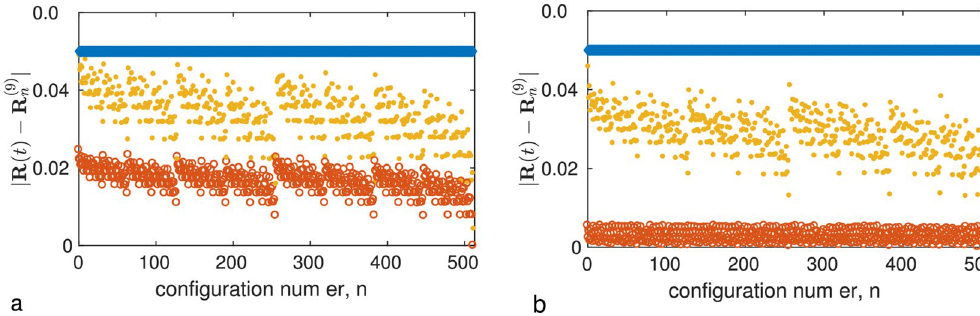
Figure 7. Numerical simulation of Eqs. (3) and (6) for a nine-leaf star network with 512 different initial ( 9 ) conditions R ( 0 ) , each of which is close to the state R n of a particular predicted asymptotic configuration with number n = 0, . . . , 511 . Panels ( a ) and ( b ) correspond to the sigmoid boundary function with µ = 0.01 and the Heaviside step boundary function, respectively. The frequencies (ω 1 , . . . , ω 8 , ω 0 , ω 9 ) , written in ascending order, are equidistantly distributed in the interval [0.6, 1]. The states R ( 0 ) are chosen so that the initial distances | R ( 0 ) − R ( 9 ) n | shown in blue squares are the same for all configurations. The yellow dots show the values of the ( 9 ) corresponding distances | R ( t ) − R n | at time t = 300 , and the red circles at time t = 76,000 . Parameter values: ε = 0.001 , τ + = 0.15 , τ − = 0.3 , and α = 1